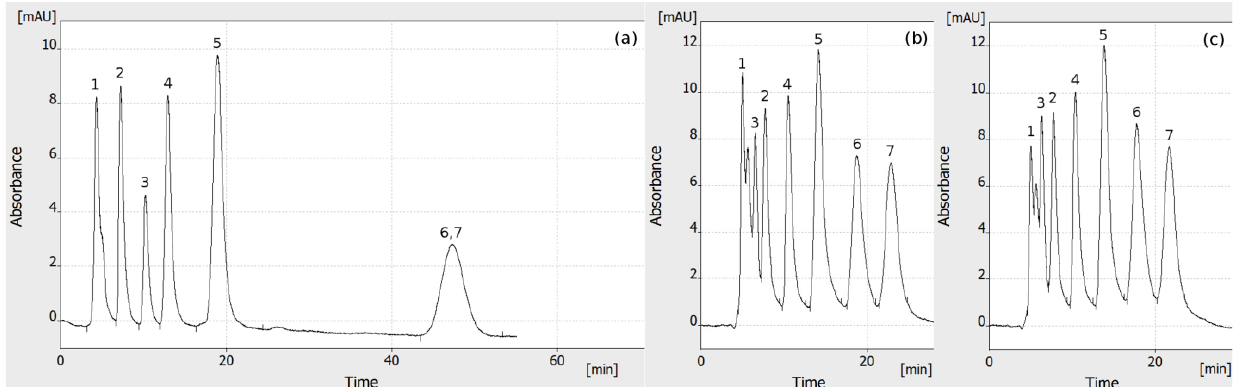
Figure 2. Comparison of single-channel ( a ) OPLC and ( b , c ) HPLEC of the dye mixture: 1 µL of the mixture was applied to the chromatographic plate (single channel), followed by the constant flow of the mobile phase from the sample pump. The separation system used was as follows: HPTLC RP-18 W chromatographic plates; water/methanol (3/2 v/v ) with addition of 80 mM ammonium formate pH 3.0 as the mobile phase; total mobile phase flow 0.33 mL/min; voltage ( a ) 0 kV, ( b ) 3.7 kV, and ( c ) 3.8 kV; temperature 25 °C, cushion pressure 100 bar; and mobile phase backpressure ( a ) 93 bar, ( b ) 82 bar, and ( c ) 80 bar. Dye mixture: 1 — indigotine 0.0125% w/v ; 2 — sunset yellow 0.025%